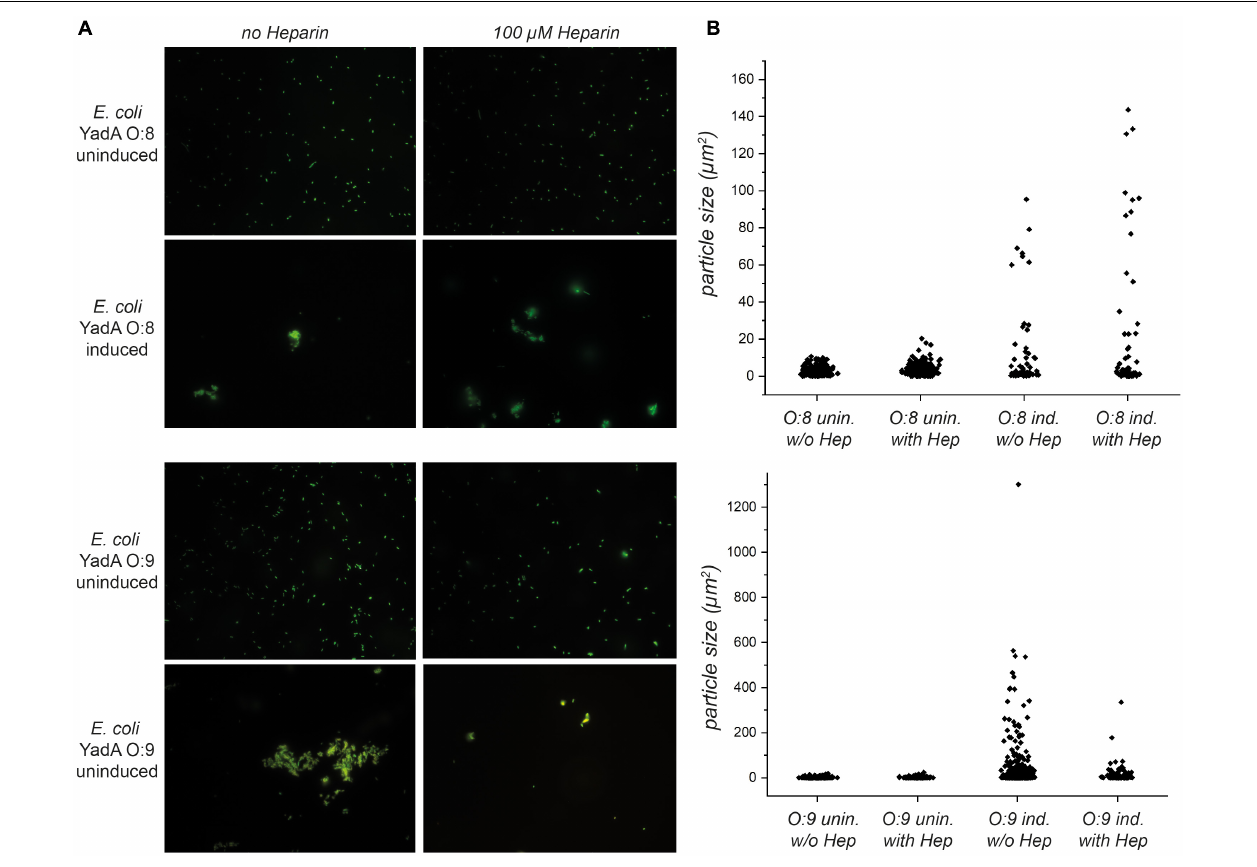
FIGURE 4 | Autoaggregation of E. coli expressing YadA O : 9 in the presence of 100 µ M heparin-disaccharide is reduced. (A) In the upper row, uninduced bacteria expressing YadA O : 8 in the presence and absence of heparin-disaccharide are shown. Uninduced bacteria (no YadA O : 8 expressed) were used as a negative control for aggregation. After induction, E. coli expressing YadA O : 8 show autoaggregation (row 2). In rows 3 and 4, the autoaggregation behavior of E. coli expressing YadA O : 9 was tested in the presence and absence of 100 µ M heparin-disaccharide. Uninduced E. coli expressing YadA O : 9 are shown in row 3, and induced samples are shown in row 4. (B) Quantifications of the area of the particles are shown in the bar scatter plots for E. coli expressing YadA O : 8 samples in the upper graph and E. coli expressing YadA O : 9 samples in the lower